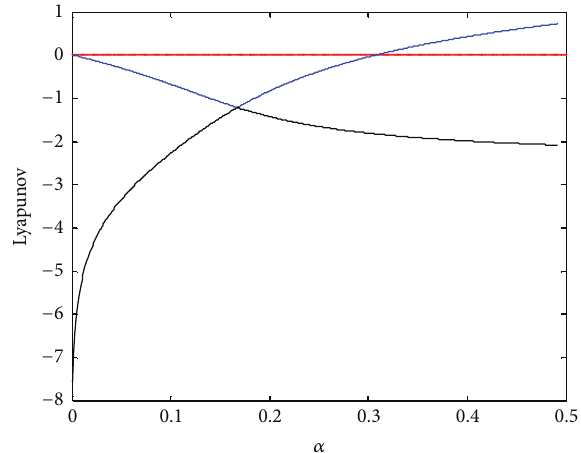
Figure 2: The related maximal Lyapunov exponents diagram as a function of the parameter 𝛼 .